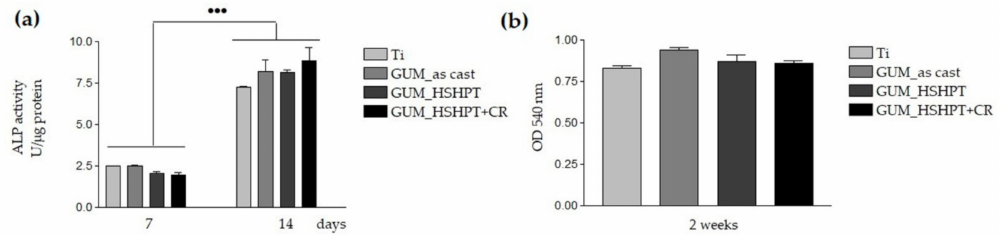
Figure 7. Di ff erentiation of the MC3T3-E1 cells cultured in contact with the Ti and GUM alloy in the as-cast state and GUM_HSHPT and GUM_HSHPT + CR substrates, as assessed by: quantification of ALP activity at 7 and 14 days post-seeding ( a ) and determination of the collagen synthesis after 2 weeks of culture ( b ). Data analysis was based on mean ± SD ( n = 3). ••• p < 0.001 for ALP activity after 14 days of culture vs. ALP activity expressed at 7 days